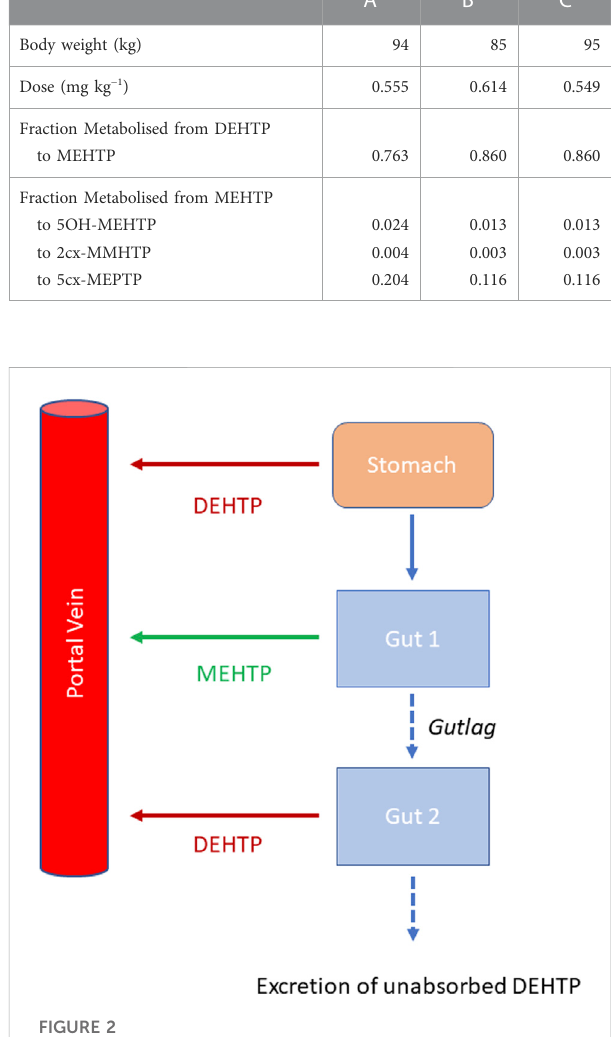
FIGURE 2 Schematic of the simpli fi ed stomach and two-stage gut